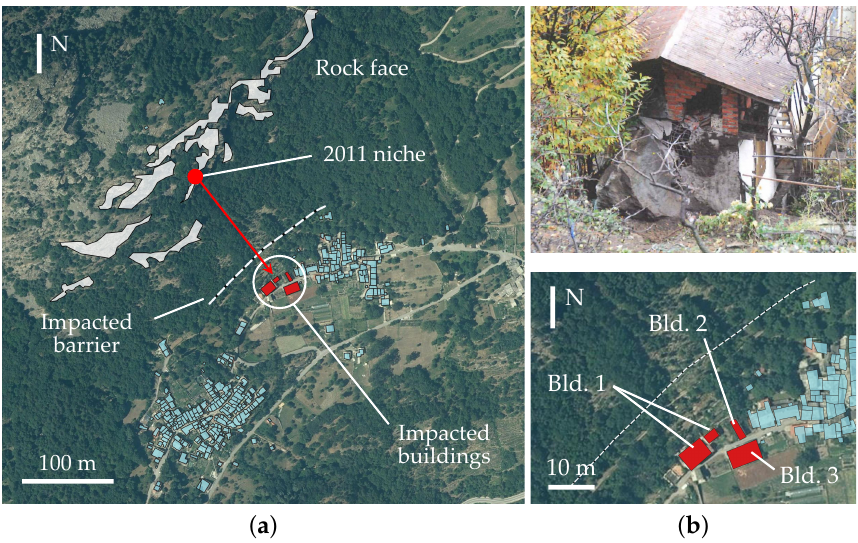
Figure 2. Overview of the site involved in the 2011 rockfall event: ( a ) Orthophoto of the Cels-Morlière area. The rock face is highlighted with a white background, the hamlet is colored in light blue, and the dotted white line refers to the flexible barrier impacted during the 2011 event. The red circle shows the detachment niche of the 2011 event, while the red arrow and the white circle indicate the estimated trajectory of the blocks and the impacted buildings; ( b ) top: (courtesy of the Piedmont Region) the observed damage on the Eastern impacted building (i.e., Bld. 2); bottom: the location of the three impacted masonry buildings within the Cels-Morlière